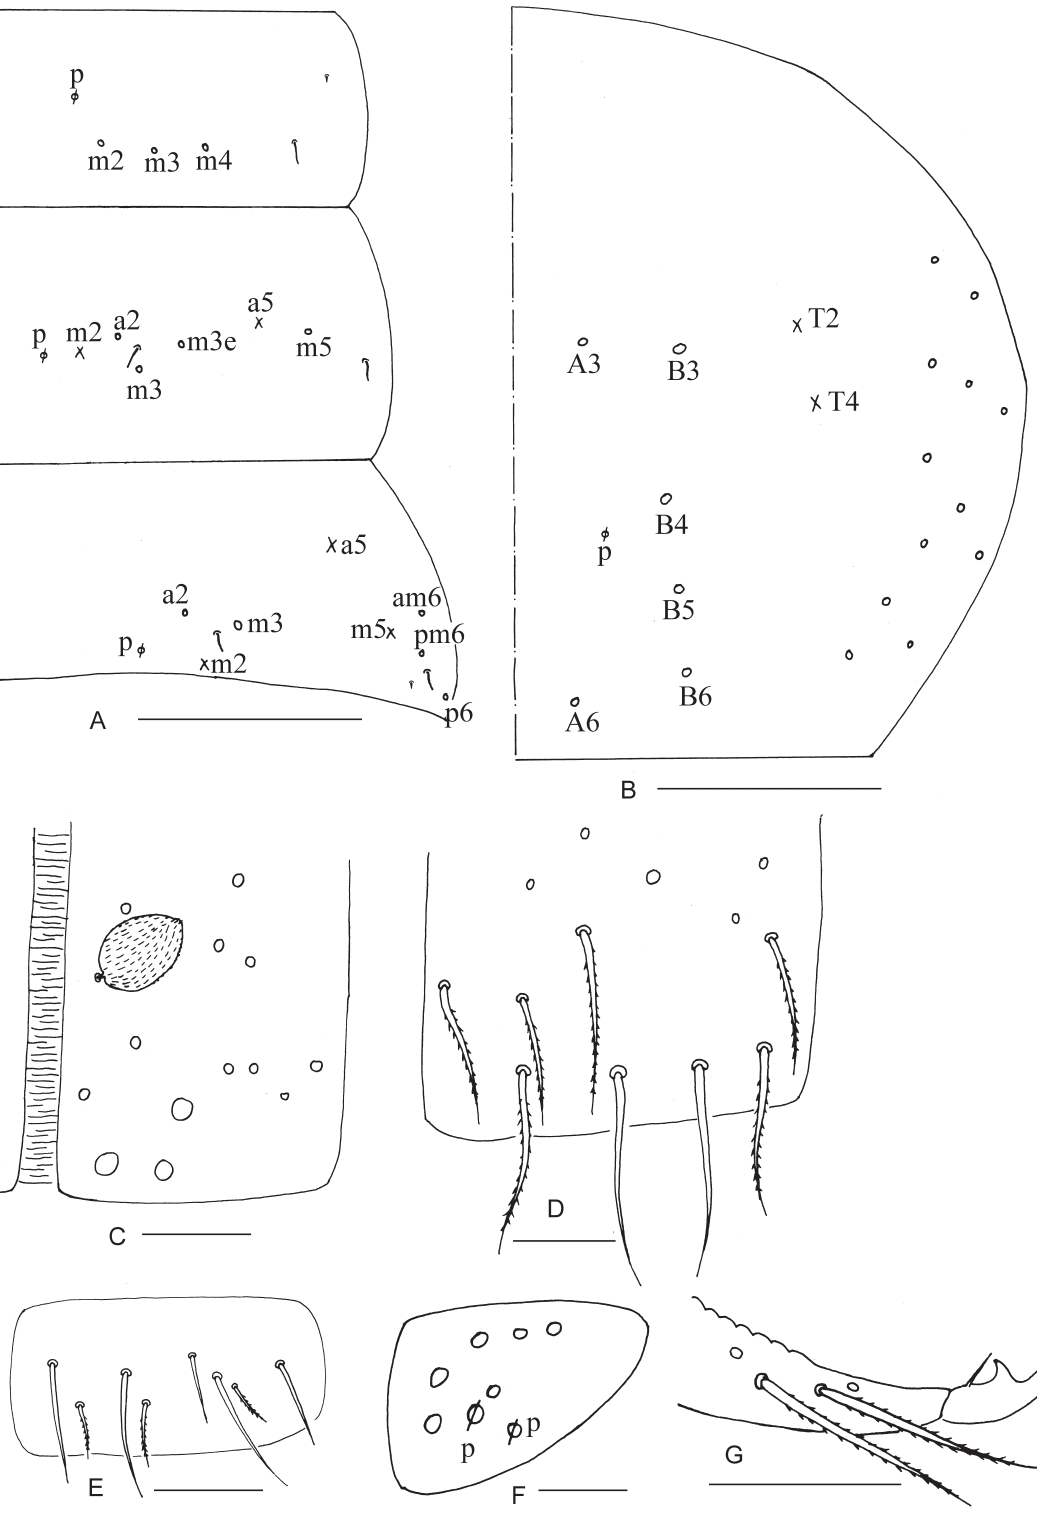
Fig. 3. Willowsia sexachaeta sp. nov. A . Chaetotaxy of Abd. I−III. B . Chaetotaxy of Abd. IV. C . Anterior face of ventral tube. D . Posterior face of ventral tube. E . Lateral flap of ventral tube. F . Manubrial plaque. G . Distal part of dens and mucro. Scale bars: A–B = 100 μm; C−G = 20